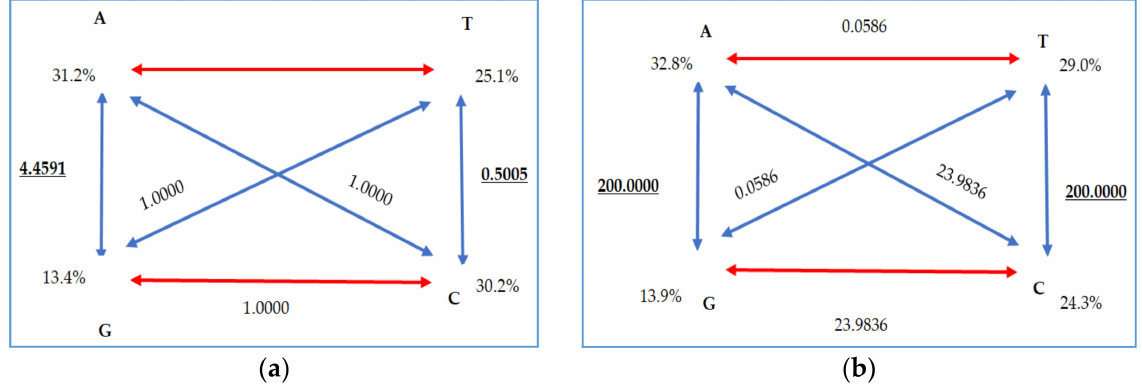
Figure 6. Substitution rates for each nucleotide, calculated in jModelTest: ( a ) cytochrome b gene sequences; ( b ) d-loop gene